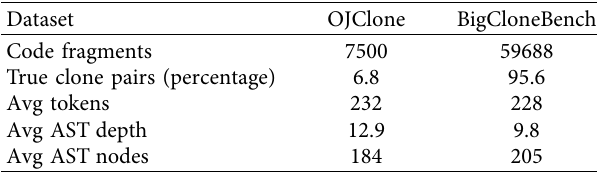
Table 2: Statistics of datasets used for clone detection.